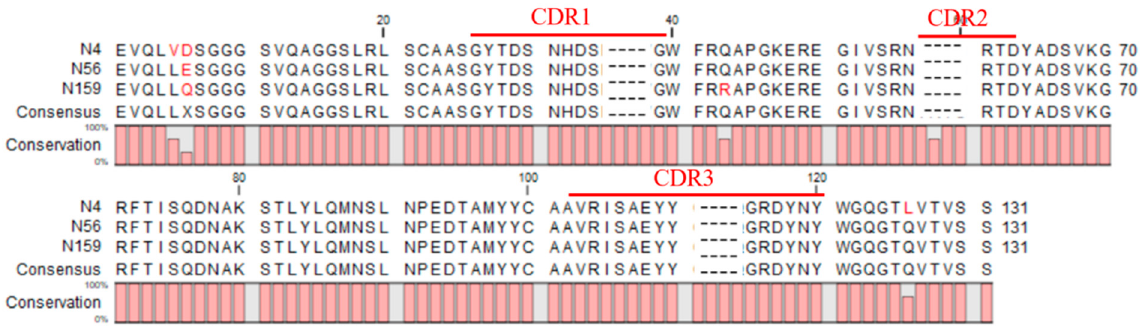
Figure 2. Positive clones identified by ic-ELISA.